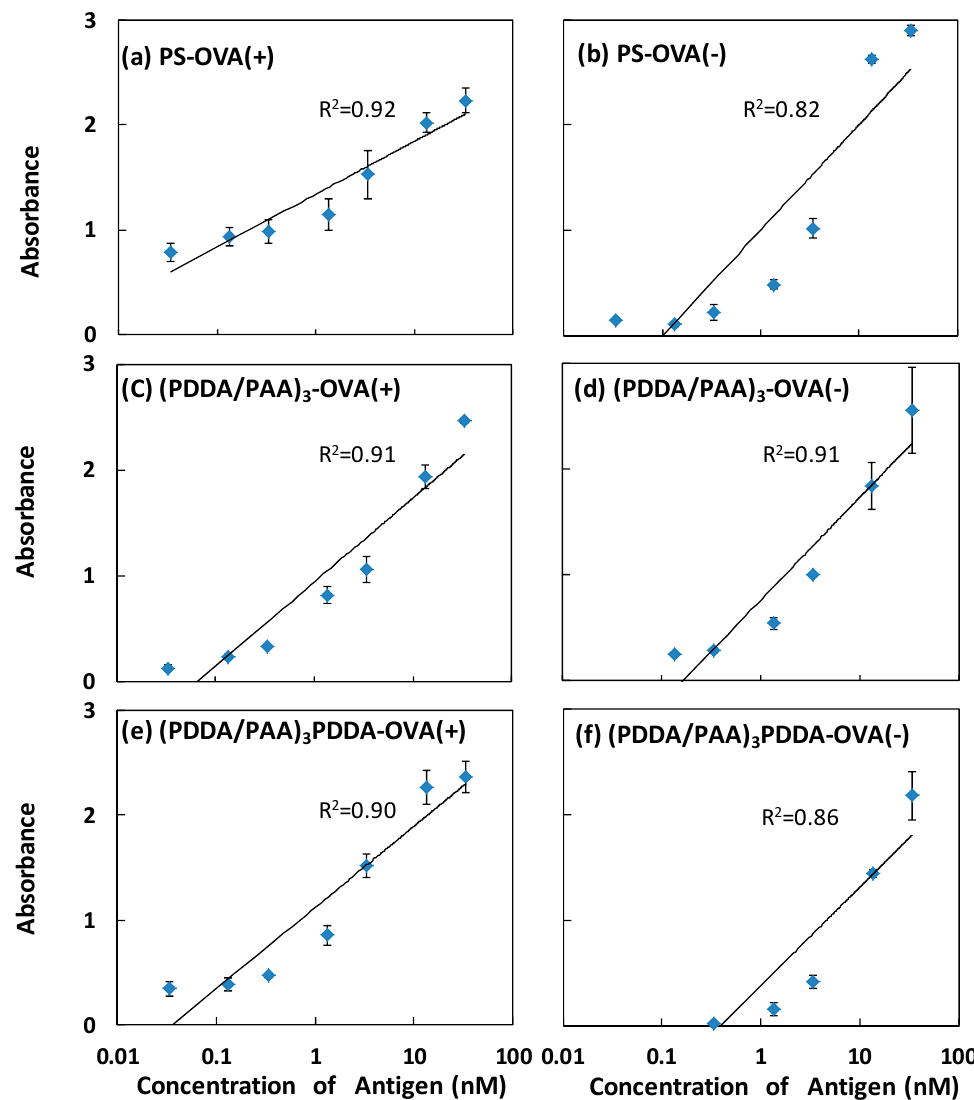
Figure 5. Specific signal as a function of antigen concentration on the PS plate ( a , b ); and the (PDDA/PAA) 3 ( c , d ); and (PDDA/PAA) 3 PDDA substrates ( e , f ); with ( a , c , e ); and without ( b , d , f ) OVA adsorption ( n = 3).